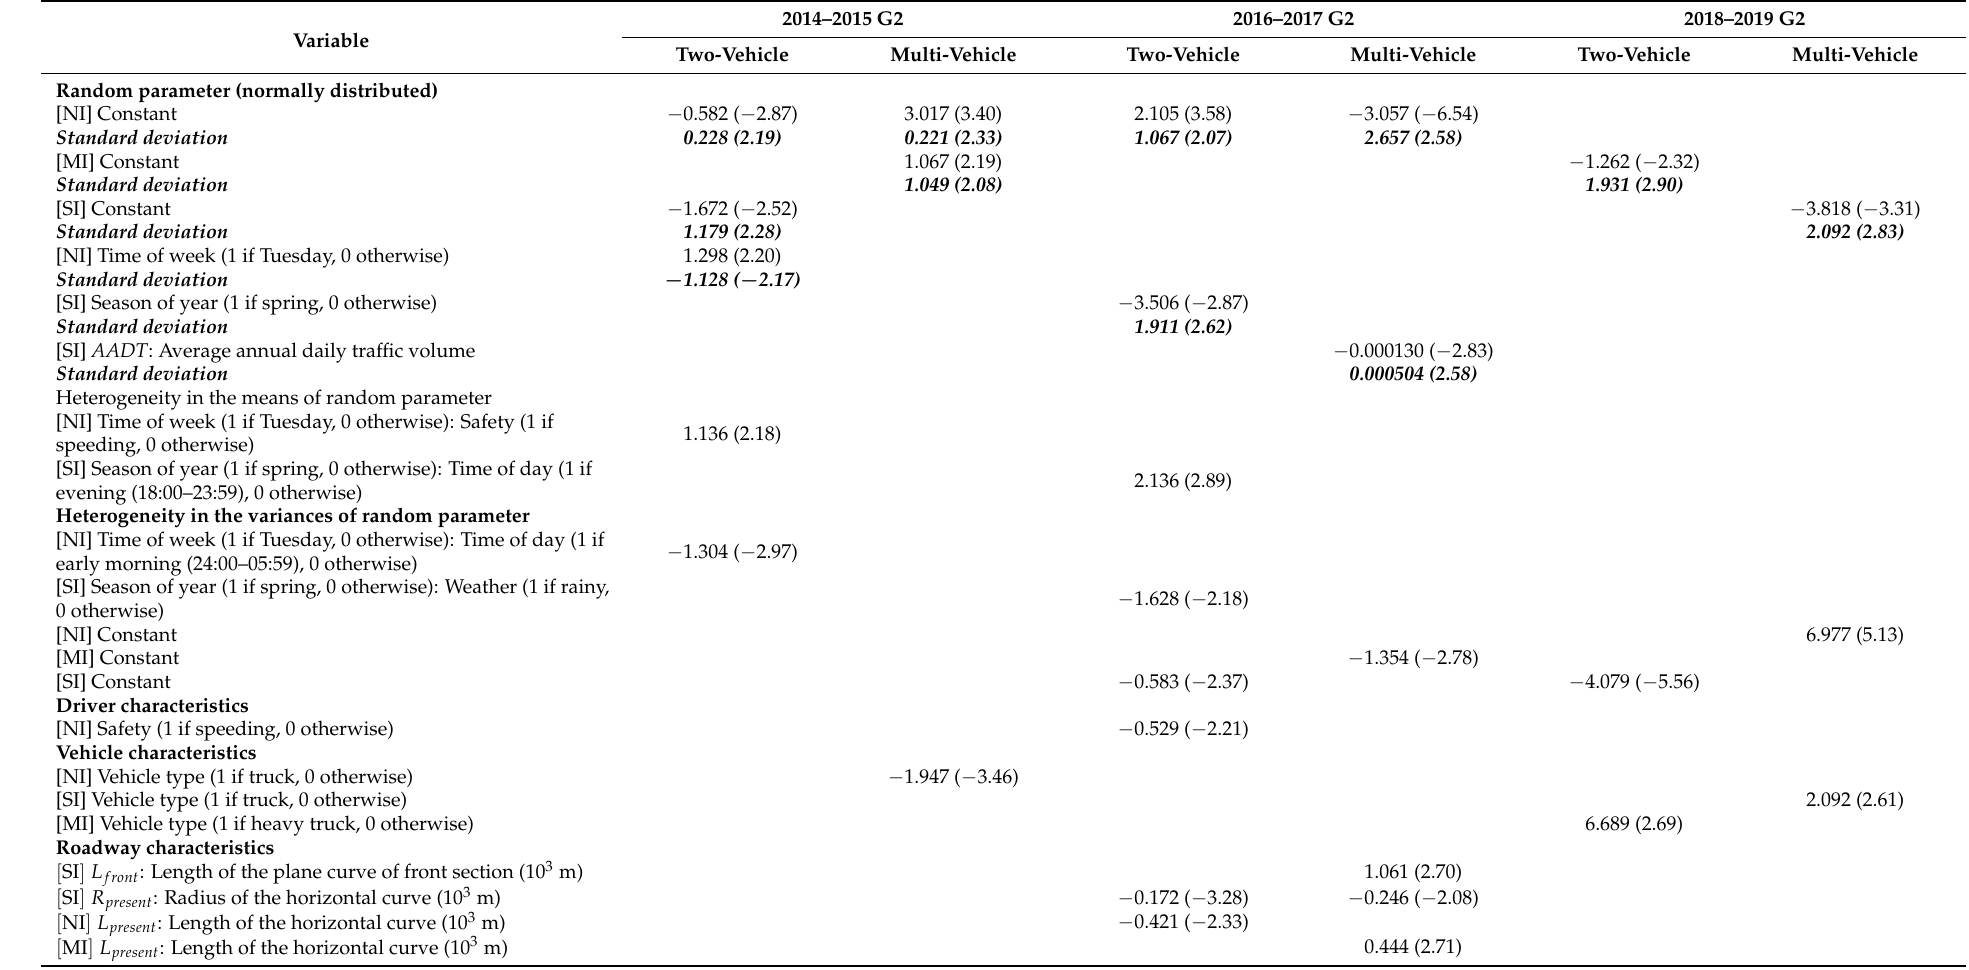
Table 4. Model results of crash severity in two-vehicle and multi-vehicle rear-end crashes in Beijing-Shanghai Freeway (G2) ( t -stat. in